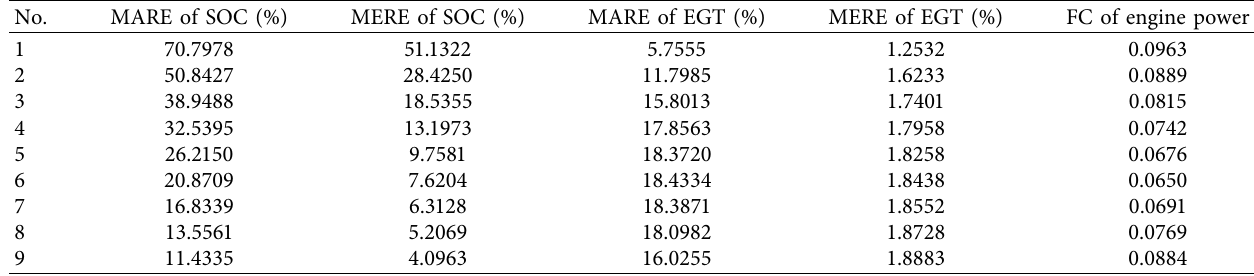
Figure 19: Simulation results comparison. (a) SOC of power battery. (b) EGTof turboshaft engine. (c) Output power of turboshaft engine. Table 10: Simulation results comparison.